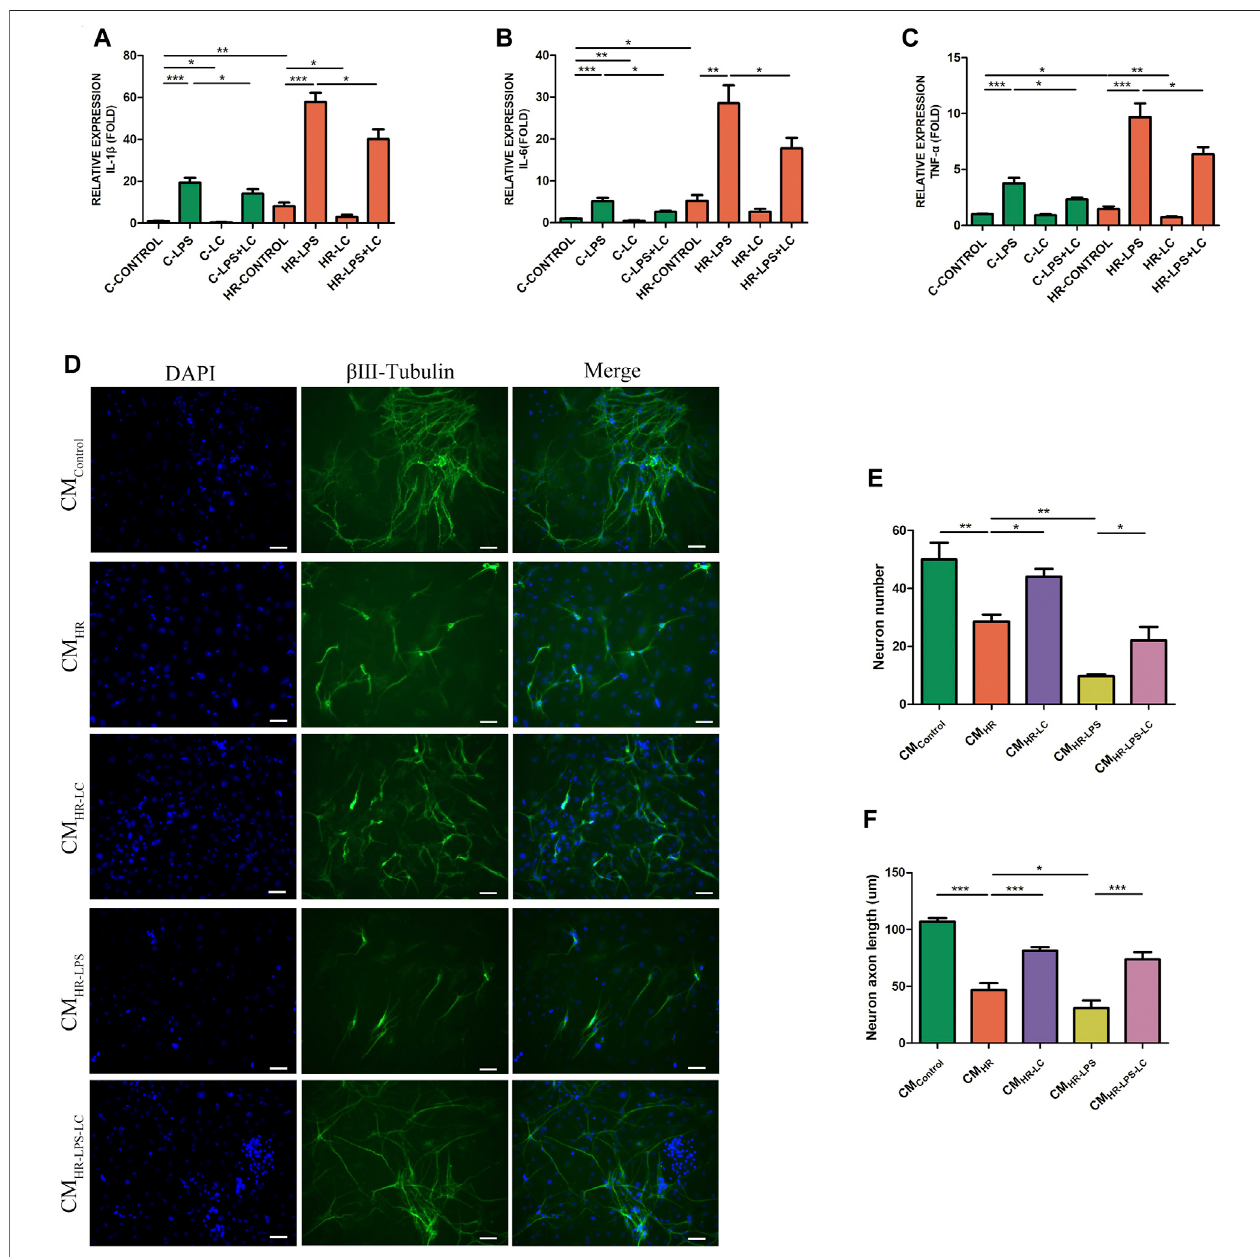
FIGURE3| L-Cysattenuatedthemyentericneuroninjuryandtheproductionofpro-in fl ammatoryfactorsintheHRmodelofPMs invitro .(A – C)ThemRNAlevelsof pro-in fl ammatory factors IL-1 β , IL-6, and TNF- α of PMs were detected under normal and HR conditions by qRT-PCR. N = 6 /group. Myenteric neurons were incubated with PM CM with or without the pretreatment of LPS and/or L-Cys under normal and HR conditions. (D) Representative photographs of immuno fl uorescent staining of β Ⅲ -tubulin (green) and DAPI (blue). Scale bar = 50 μ m. N = 4 /group. (E,F) Quantitative analyses of the number of neurons and the length of axons. Six randomly captured images per animal were analyzed for each group. N = 4 /group. Values are mean ± SEM , * p < 0.05, ** p < 0.01, and *** p < 0.001 according to ANOVA with the Newman – Keuls test.